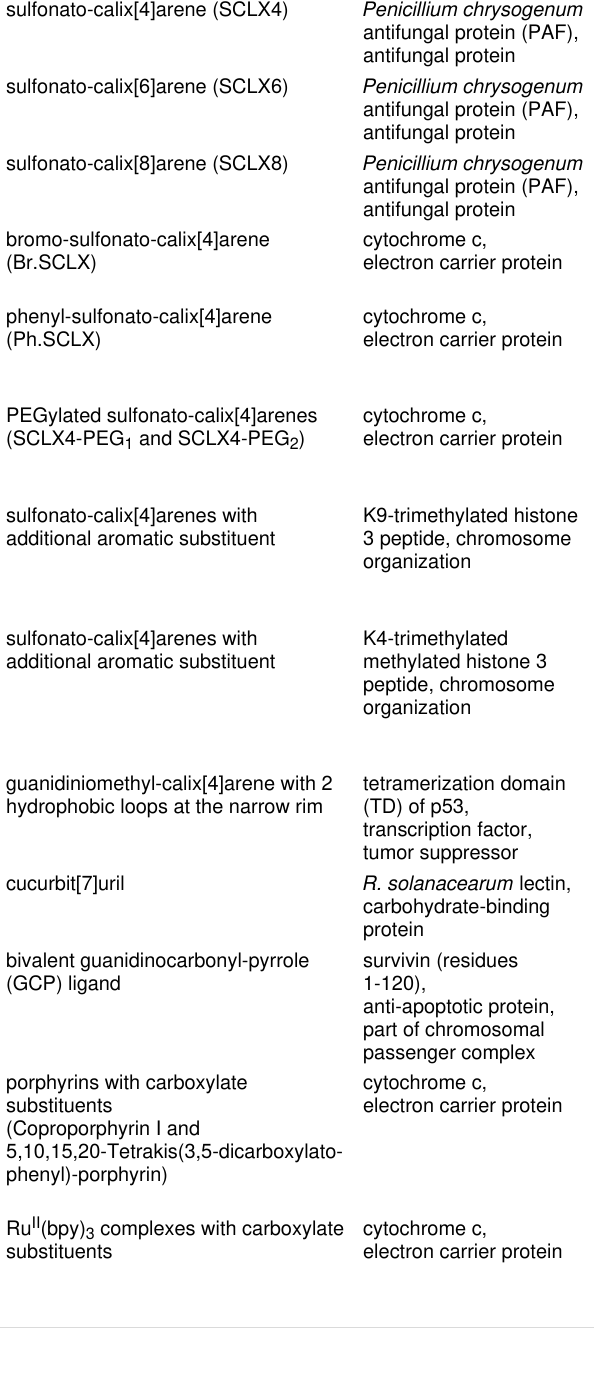
Table 1: Summary of NMR studies on supramolecular ligands binding to protein surfaces. (continued) sulfonato-calix[4]arene